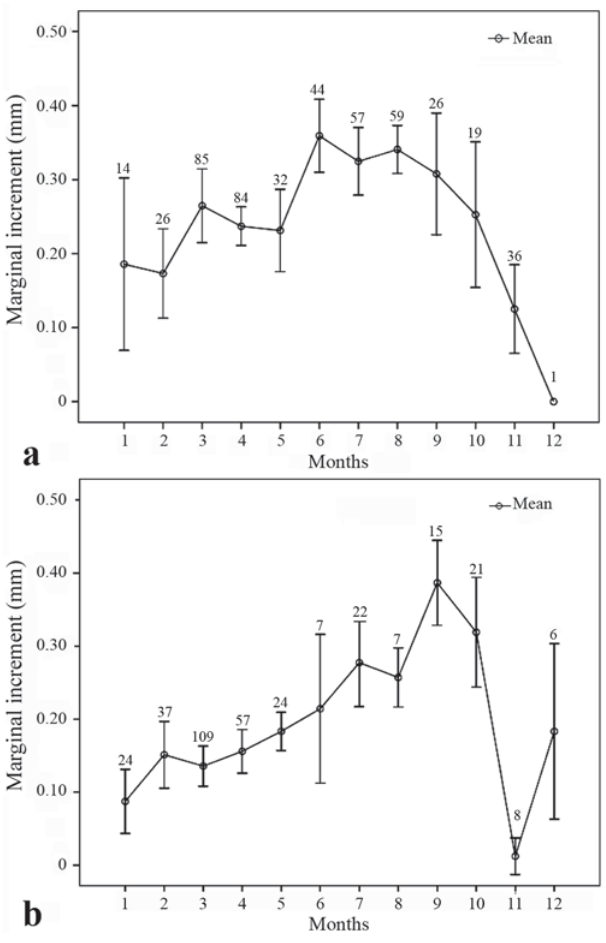
Fig. 4. Marginal increment with mean and 95% confidence intervals for young specimens (a) and for adults (b) of Scomberomorus brasiliensis in the northeastern